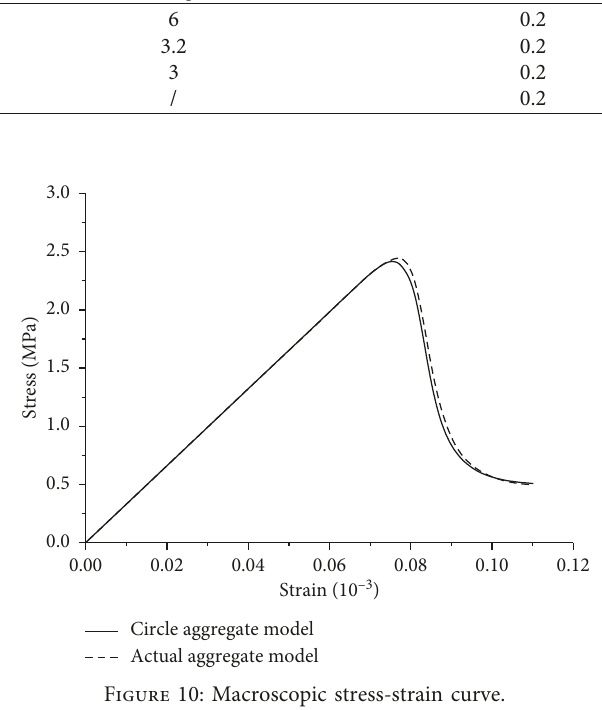
Figure 10: Macroscopic stress-strain